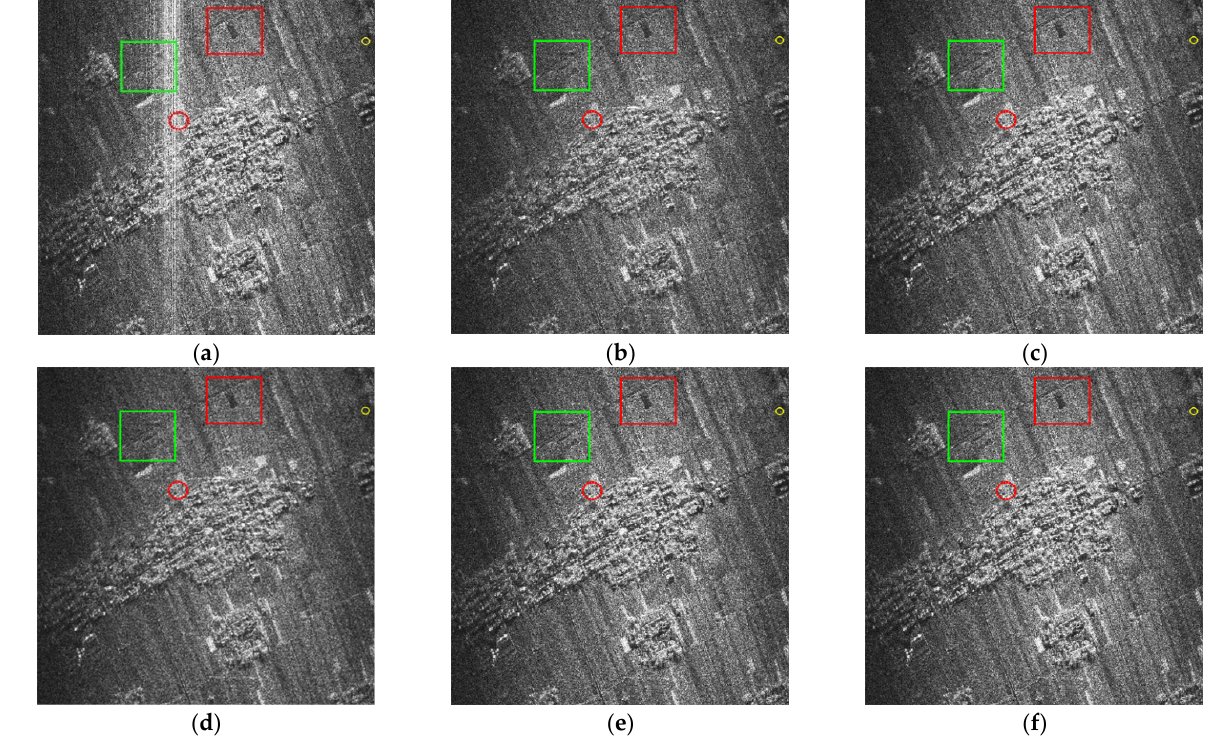
Figure 17. Resulting SAR image after applying ( a ) the SAR imaging algorithm applied directly for the original data, ( b ) ISNF, ( c ) ESP, ( d ) GoDec, ( e ) LRDS, and ( f ) TFC-LRS.